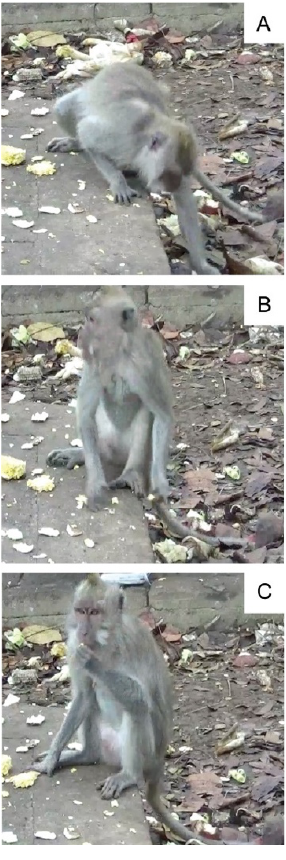
A Long-tailed Macaque Named “Langur” Reaching for a Small Food